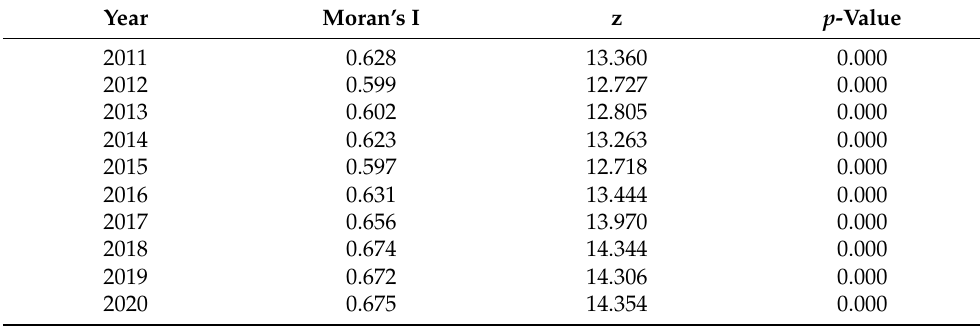
Table 3. Global Moran’s I of non-grain production from 2011 to 2020.